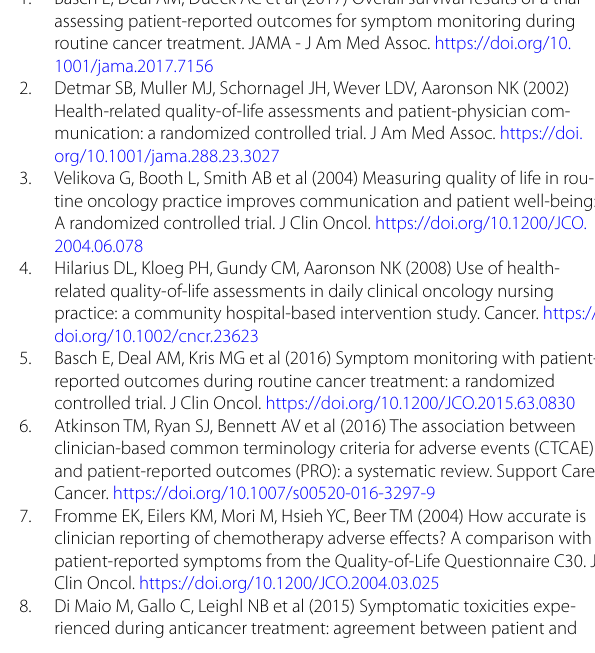
Figure S1 : shows a sample user interface of the ePRO platform, where patients can view there overall symptom scores (top left), can record type of symptom overall (top right), and fill out the specific symptoms in the symptom questionnaire (bottom panel). Acknowledgements Not